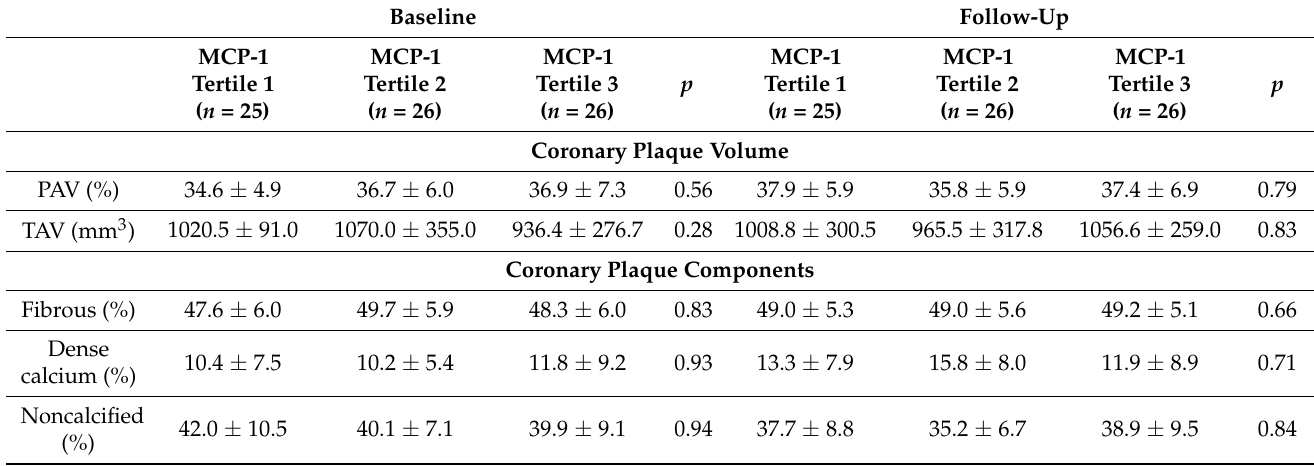
Figure 3. Correlations between the ( Δ ) change in MCP-1 plasma concentration and the changes in the daily intake of selected nutrients. DASH Group: ( A ), correlation between change in MCP-1 plasma concentration and change in Vitamin C intake; ( B ), correlation between change in MCP-1 plasma concentration and change in fibre intake. Control group: ( C ), correlation between change in MCP-1 plasma concentration and change in Vitamin C intake; ( D ), correlation between change in concentration of MCP-1 and change in fibre intake. Values are mean ± SD. Table 5. Analysis of the atherosclerotic plaque composition for tertiles of the MCP-1 plasma concentration in the whole study group. p -values were obtained with linear regression analyses with continuous plaque volumes and plaque components’ volumes as independent